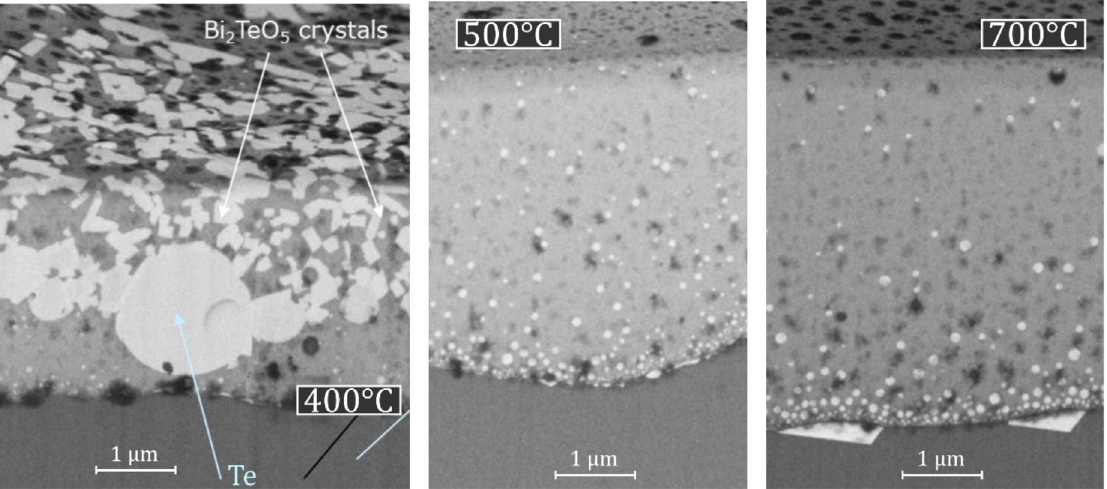
Fig. 3. SEM cross section images of a non-passivated sample for different RTP peak fi ring temperatures (400 ° C left, 500 ° C middle, 700 ° C right). At 400 ° C, there are large Te crystallites (bright blue arrow) as well as smaller Bi 2 TeO 5 crystals (white arrows) visible, whereas the crystallization diminishes for higher peak temperatures. For 700 ° C Te crystallites grown into the Si wafer are visible.